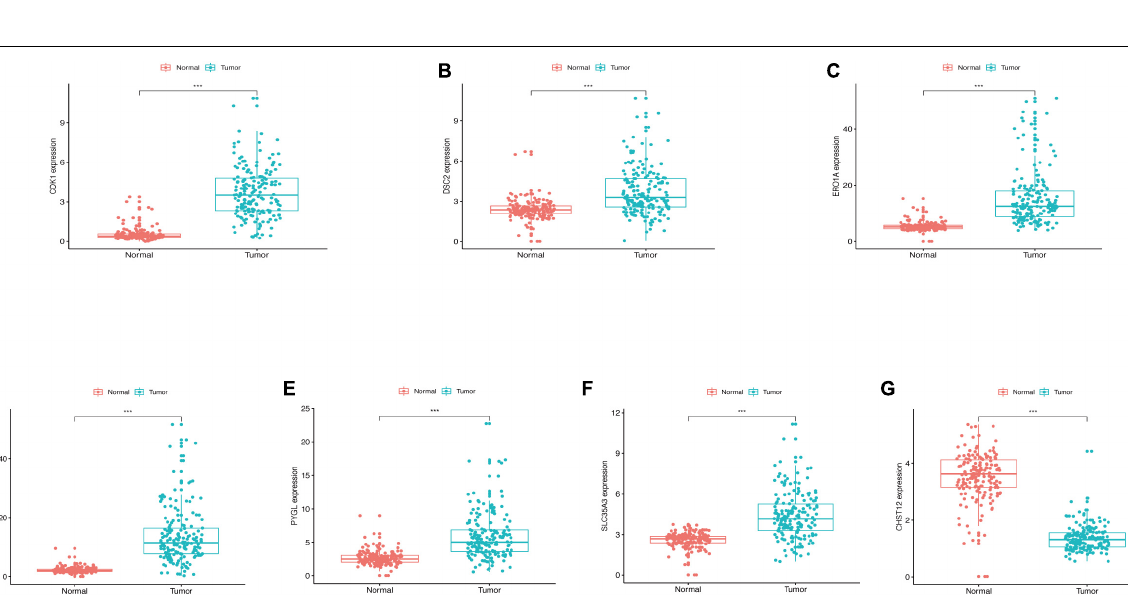
Frontiers in Cell and Developmental Biology |